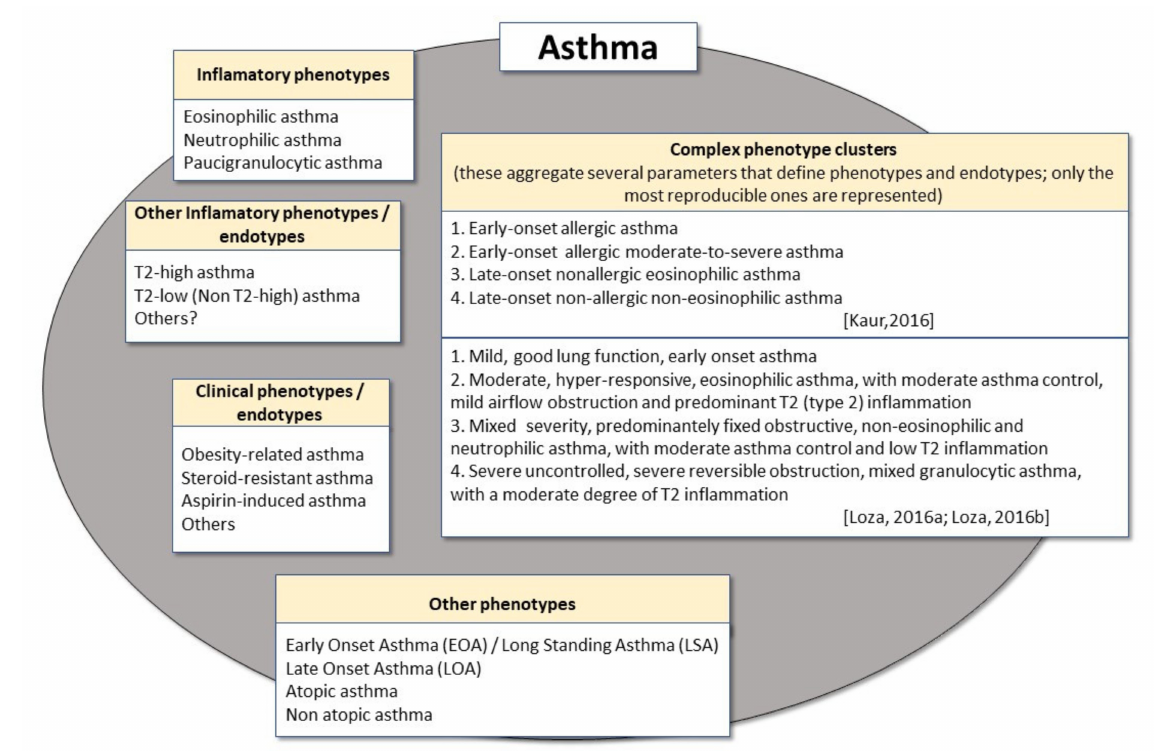
Figure 1. General outline of some of the most frequently analysed asthma phenotypes, endotypes and phenotype clusters in